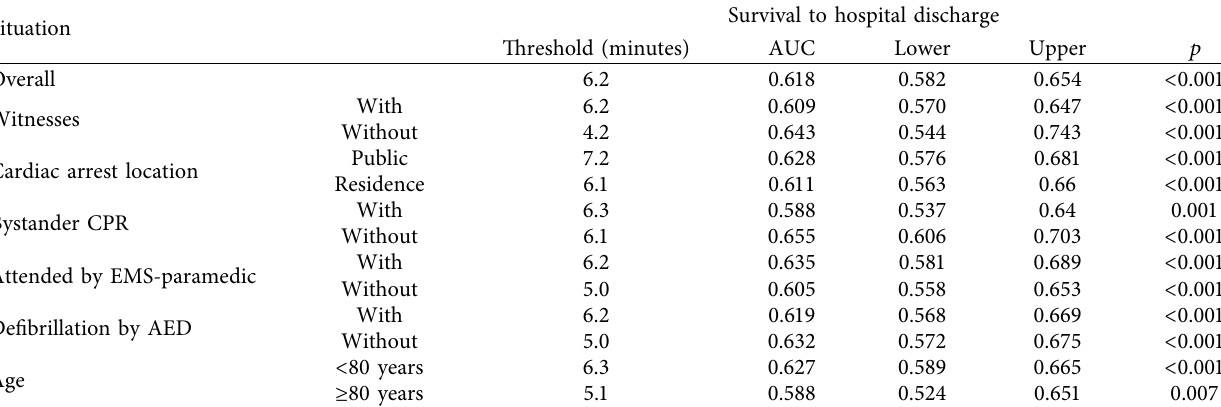
Table 3: Receiver operating characteristic (ROC) curve analysis of the optimal response time threshold for predicting survival to hospital